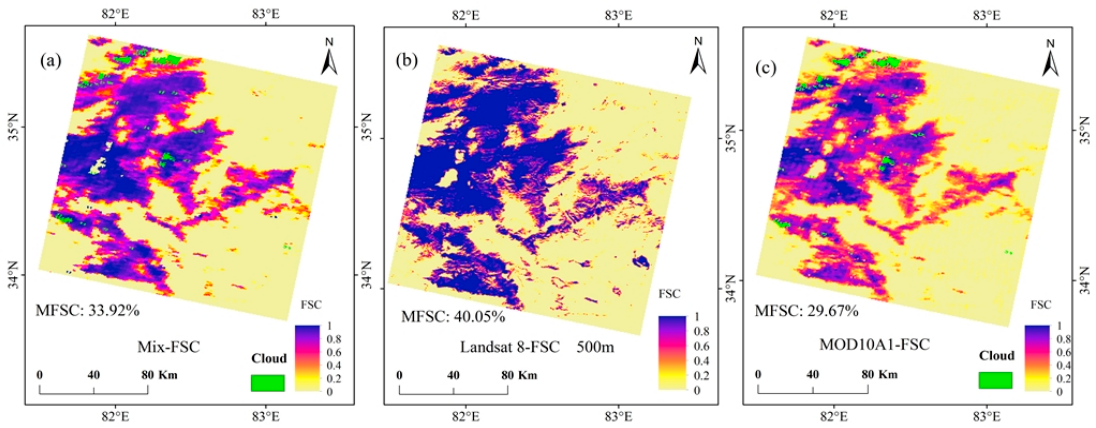
Figure 7. Comparison of the FSC spatial distributions from the LSMA model ( a ), Landsat 8 OLI ( b ) and MOD10A1 ( c ) in validation sub-region V1 on 14 October 2016.